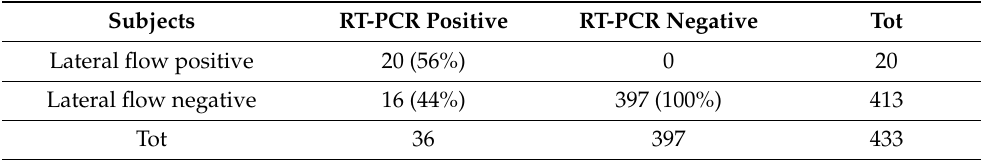
Table 2. Results of the screening of the lateral flow test compared with RT-PCR in asymptomatic subjects for SARS-CoV-2